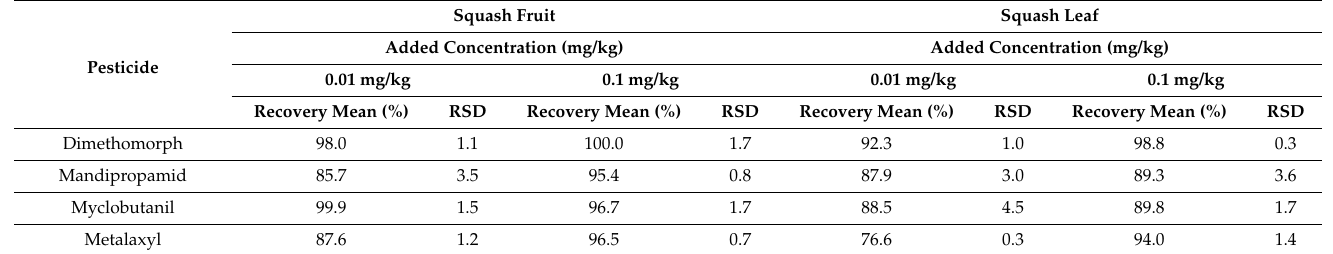
Table 3. Recovery tests in squash fruit and